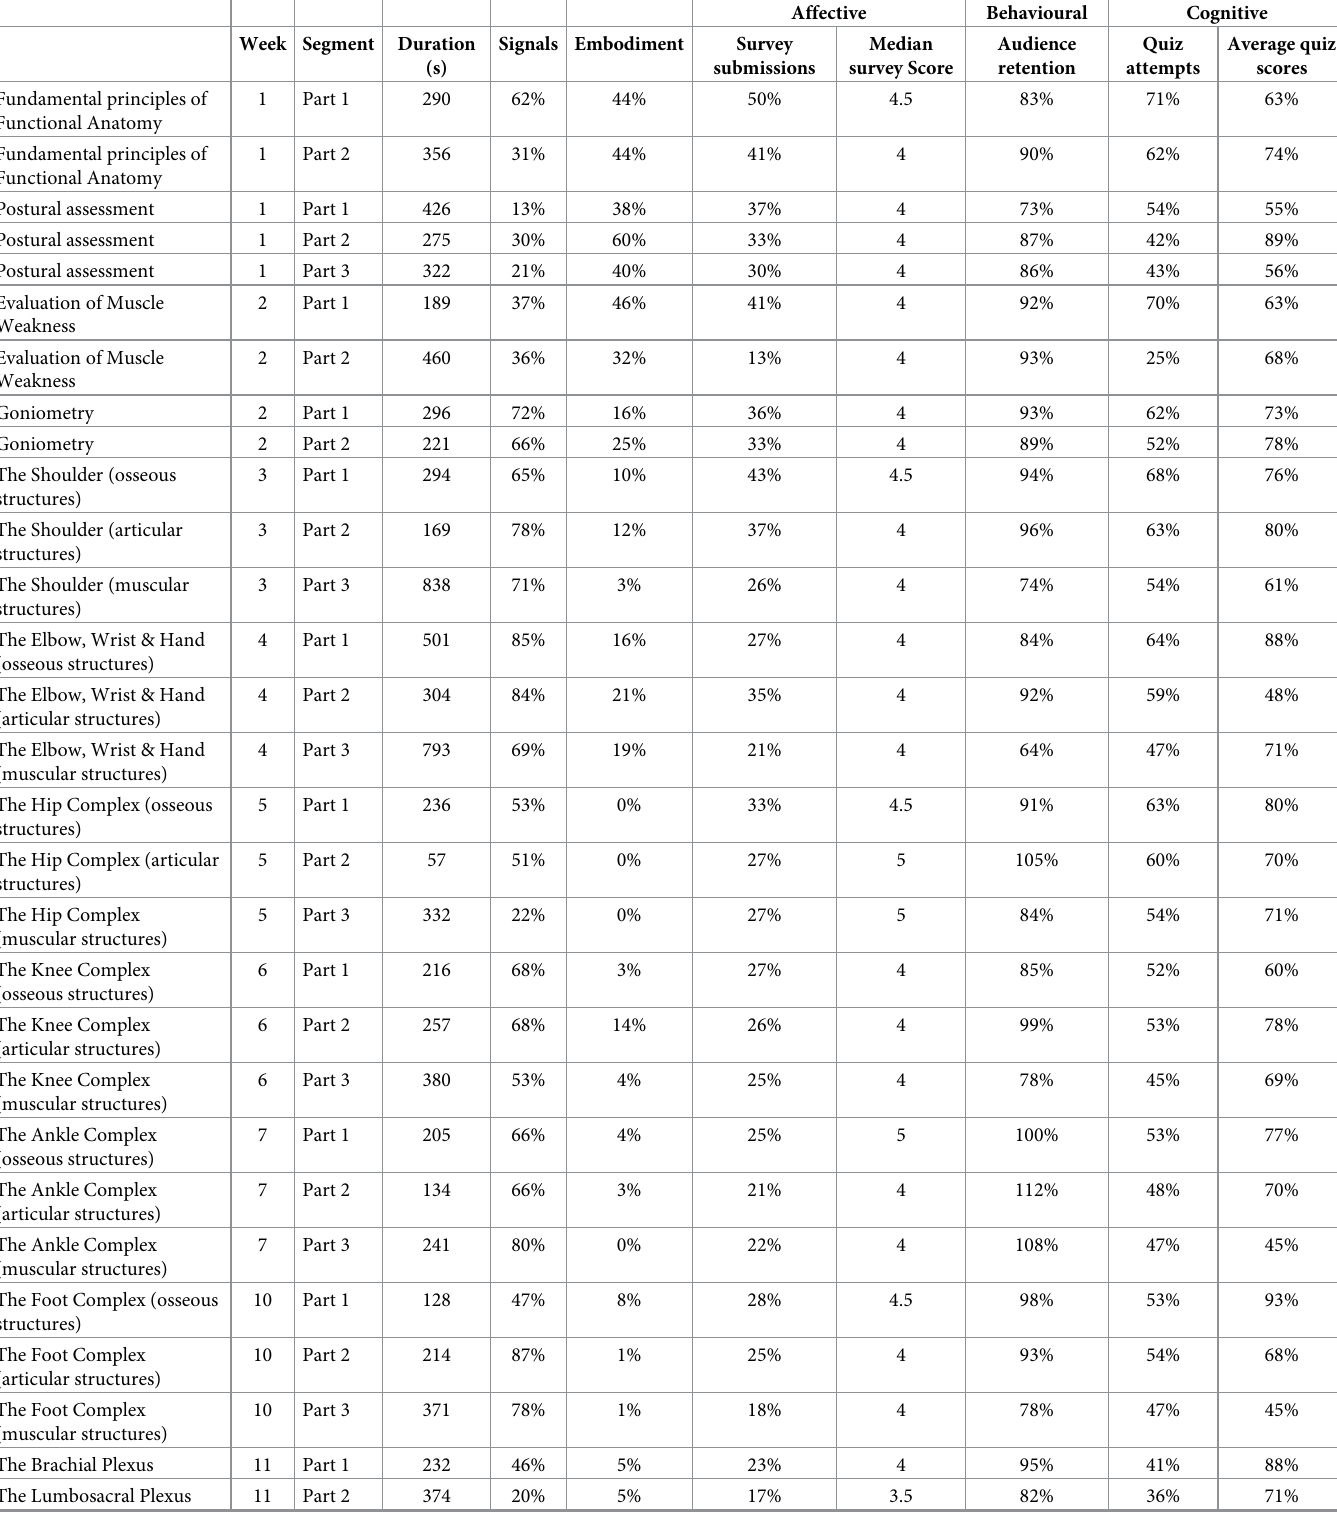
Table 2. The multimedia lecture characteristics and descriptive statistics for affective, behavioural and cognitive